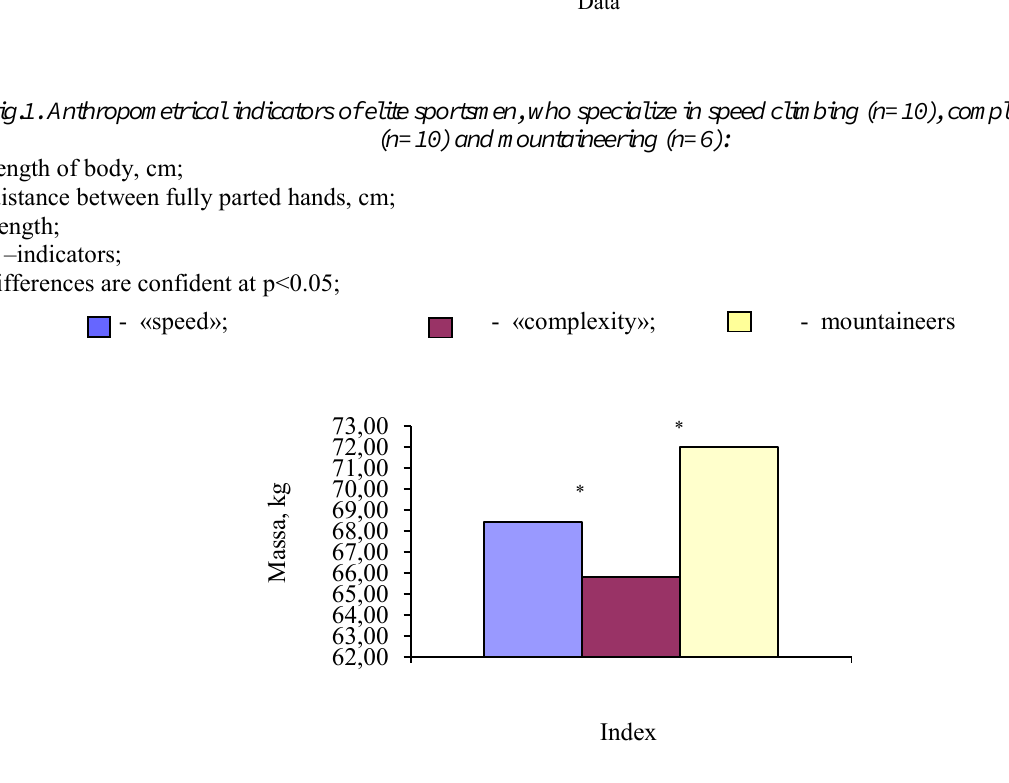
Fig.2. Body mass of elite sportsmen, who specialize in speed climbing (n=10), complex climbing (n=10) and mountaineering (n=6): * - differences are confident at